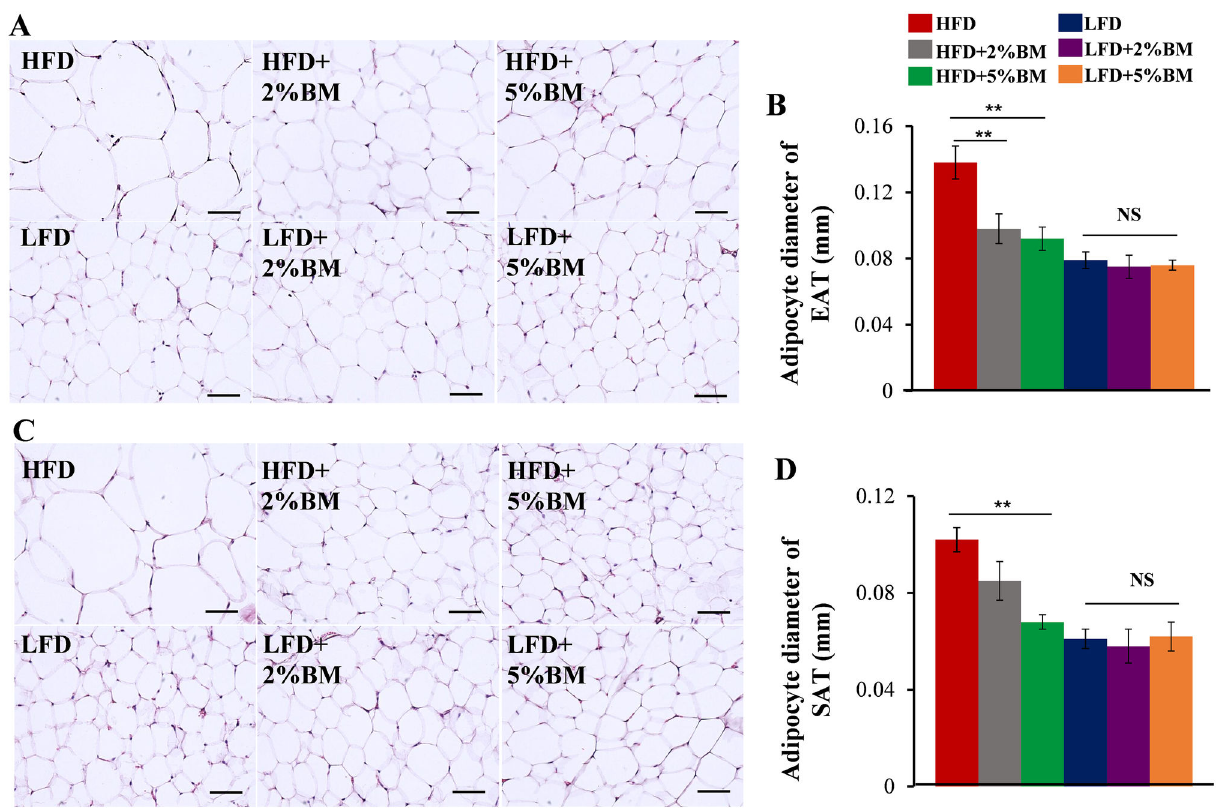
Figure 2. Bitter melon reduced adipocyte size in mice fed with HFD. HE staining of EAT (A) and SAT (C) in mice, scale bars are 50 μm in the length. (B) Quantification of EAT adipocyte diameter and (D) SAT adipocyte diameter. (Data were collected from H&E-stained sections from eight individual mice, five fields per mouse, using Image-Pro Plus 6.0 software) Statistical difference between groups is shown using a nonparametric Mann-Whitney test. n=8 per group. * P <0.05, ** P <0.01. All data are means ± SEM. doi: